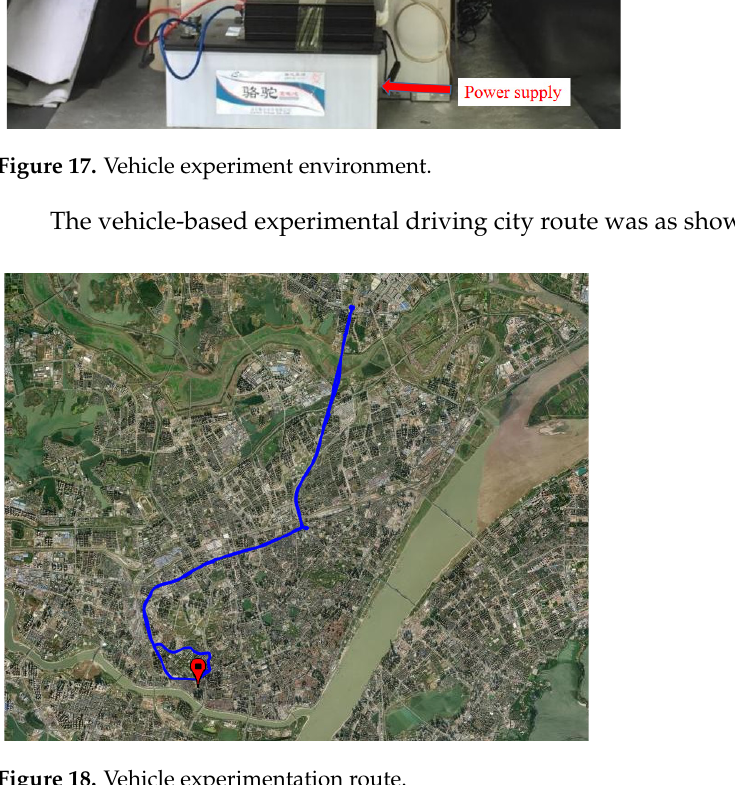
Figure 18. Vehicle experimentation